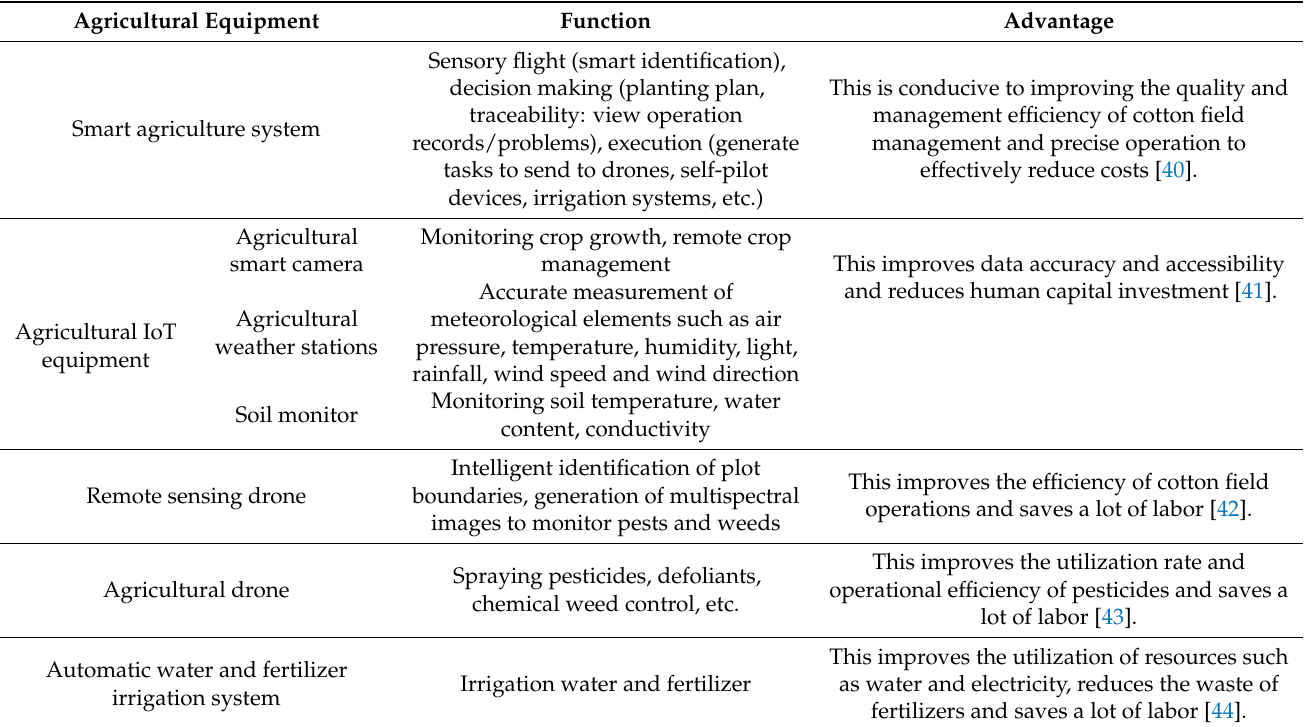
Table 1. Smart devices are used in the management of Super Cotton Field